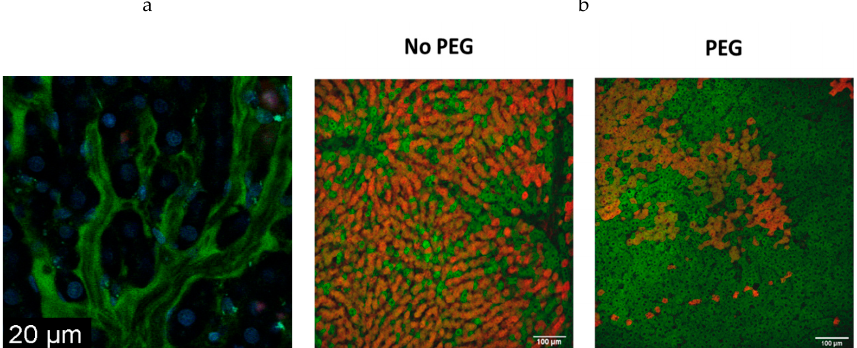
Figure 2. Electron microscopy imaging showing effects of PEG35 on rat liver. ( a ) Intravital microscopy of rat liver perfused with PEG35 covalently conjugated to FITC (green). Cell nuclei were labelled with intravenous injection of Hoescht 33, 342 (blue). PEG35 is deposited in the liver vascular bed. Male Sprague-Dawley rats were treated with PEG35 (10 mg/kg) and then subjected to 1 h ischemia followed by 2 h reperfusion. ( b ) Ex vivo two-photon imaging of liver grafts labelled with rhodamine 123 (green) and propidium iodide (red), showing polarized mitochondria and dead cells respectively. Liver grafts were worse preserved when they were rinsed with a solution without PEG35 (left) than with the same solution containing PEG (right). Images show better preservation of polarized mitochondria in PEG rinsed livers, as well as smaller size of cells and more compact structure, indicating that PEG, as oncotic agent, prevents cell swelling and interstitial edema.